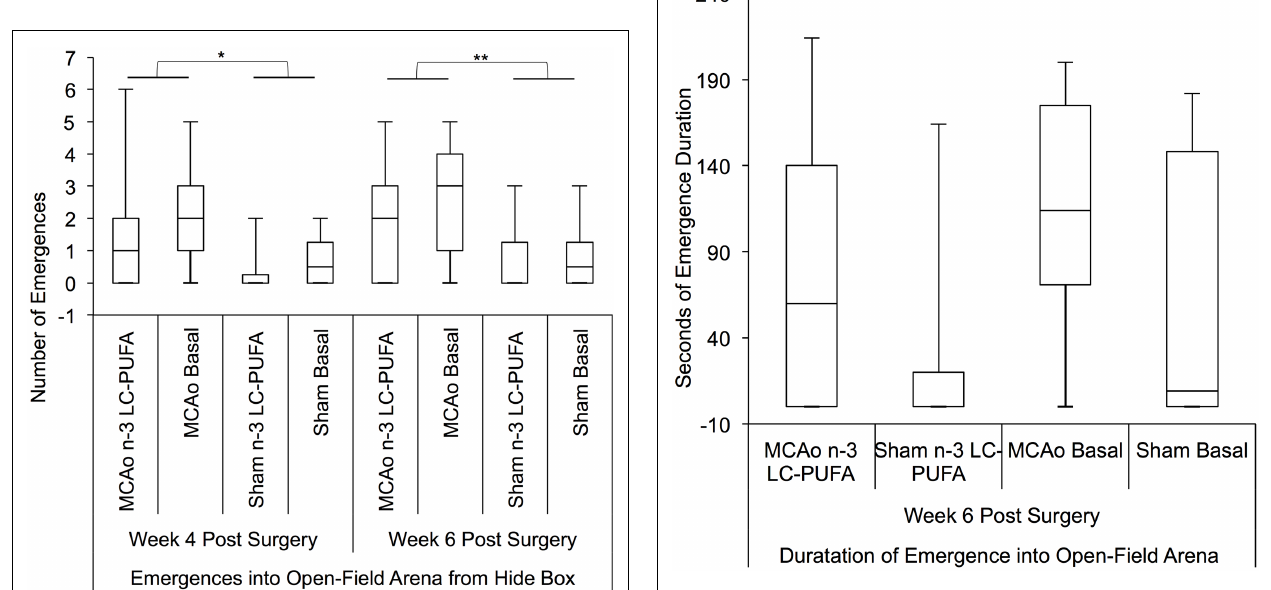
FIGURE 6 | Box plots showing significant post hoc differences in number of emergences into open field, between diet and surgery conditions .Visual inspection of this Figure indicates that sham surgery-operated animals were less active than MCAo operated animals and that in each surgery condition, at each time point, the n -3-LC-PUFA animals emerged from the hide box less often, suggesting less hyperactivity. MCAo, middle cerebral artery occlusion surgery condition; Sham, Sham surgery condition; Basal, basal diet fed rats; n -3-LC-PUFA, polyunsaturated fatty acid supplemented rats. n = 11 n -3-LC-PUFA MCAo; n = 13 Basal MCAo; n = 12 n -3-LC-PUFA sham; n = 12 Basal Sham.